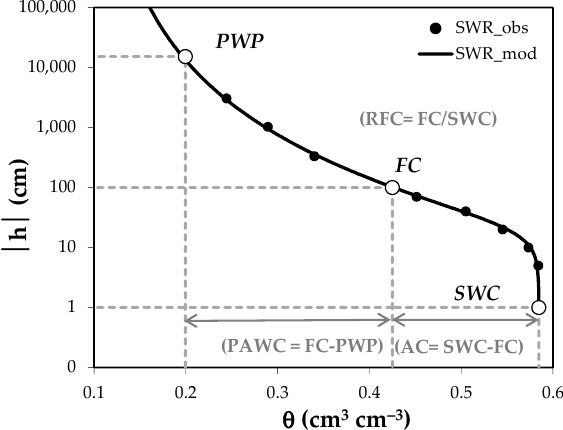
Figure 2. Schematic representation of the soil water retention curve (SWR; observed, obs, and modeled, mod) to show the calculation of air capacity (AC), plant available water capacity (PAWC), and the relative field capacity (RFC) of the soil. PWP, FC, and SWC are the abbreviations for permanent wilting point, field capacity, and saturated soil water content, respectively.